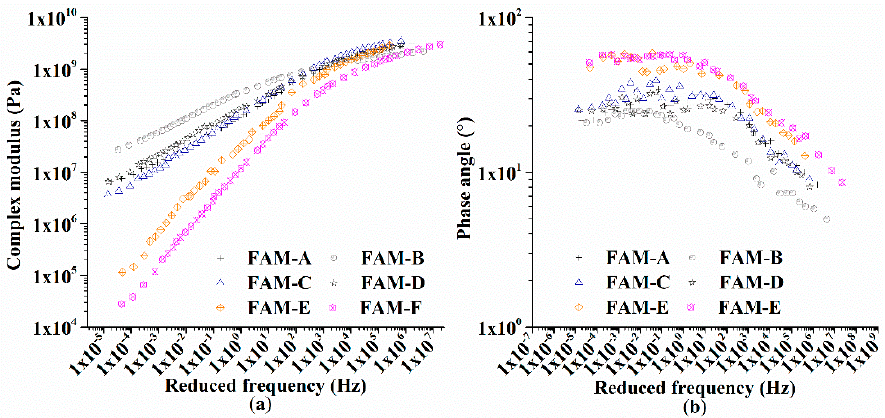
Figure 9. Master curves of FAM at 30 °C: ( a ) complex modulus (| G * |), and ( b ) phase angle (°).